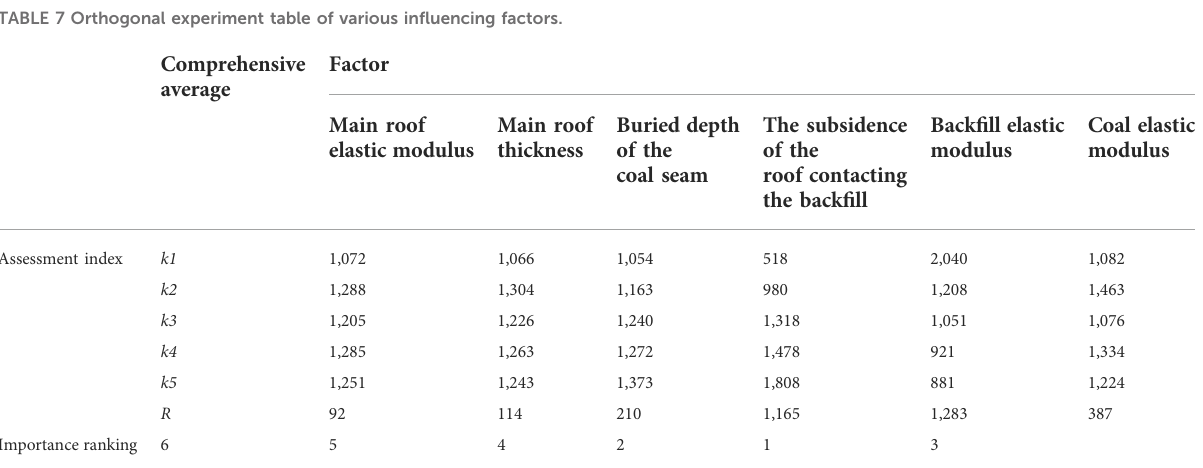
TABLE 7 Orthogonal experiment table of various in fl uencing